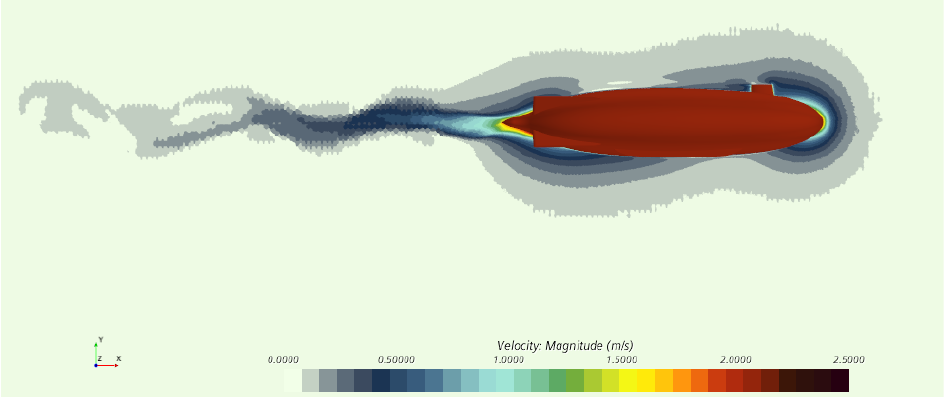
Figure 3. Velocity contour of pure heave maneuver from CFD.